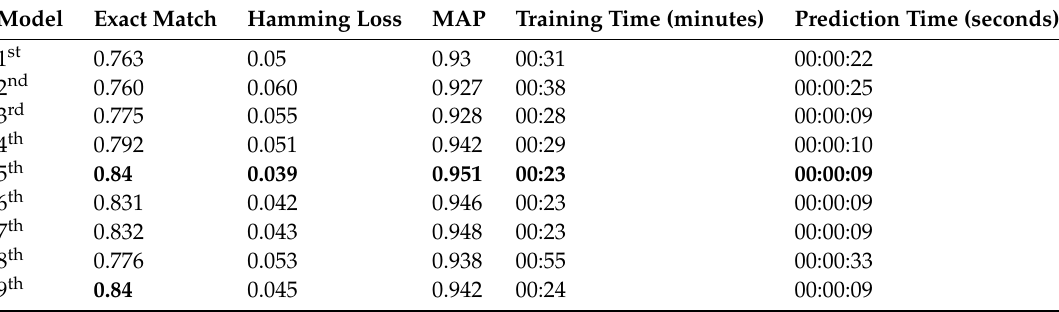
Table 5. Hamming loss, exact match ratio, and training and prediction